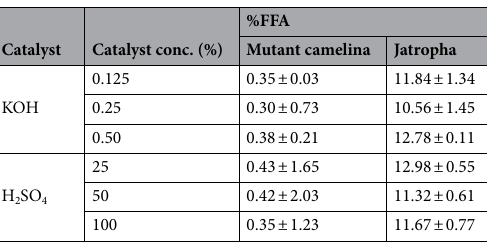
Table 4. Viscosity (centipoise) of biodiesel from mutant camelina and jatropha.